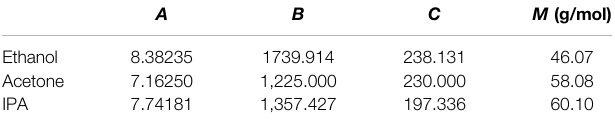
TABLE 1 | Antoine constants and molecular weight of volatile